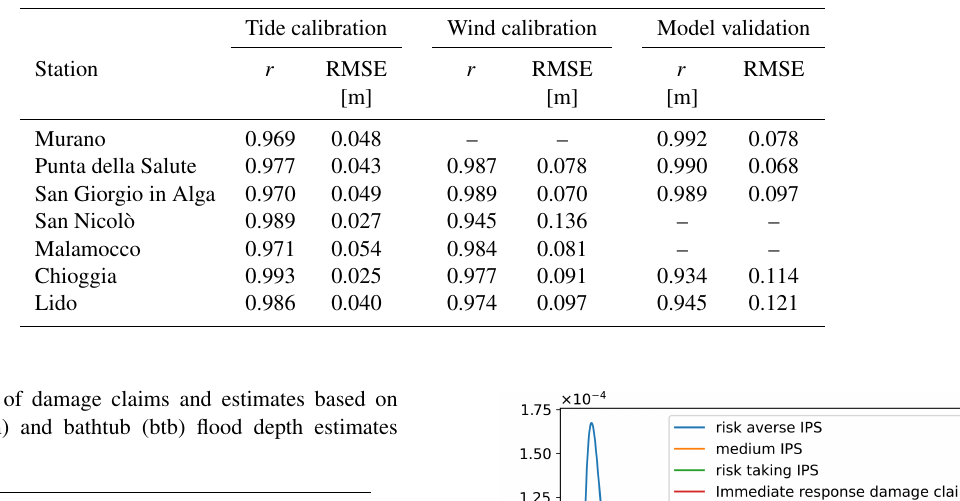
Table 7. Parent model performance.